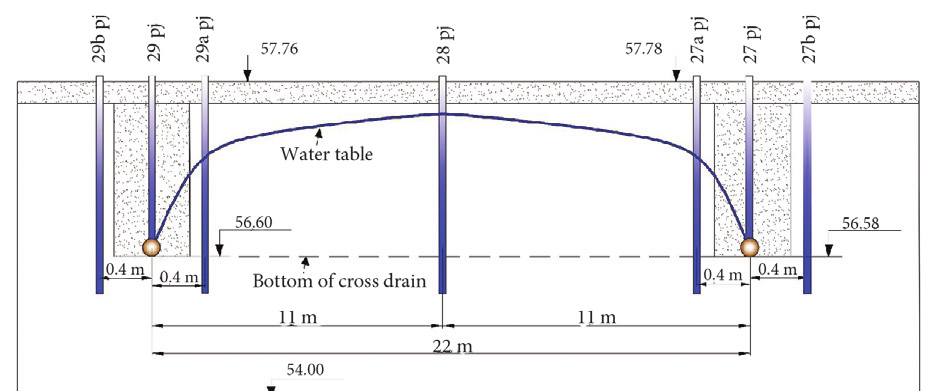
Fig. 3. The piezometers of experimental